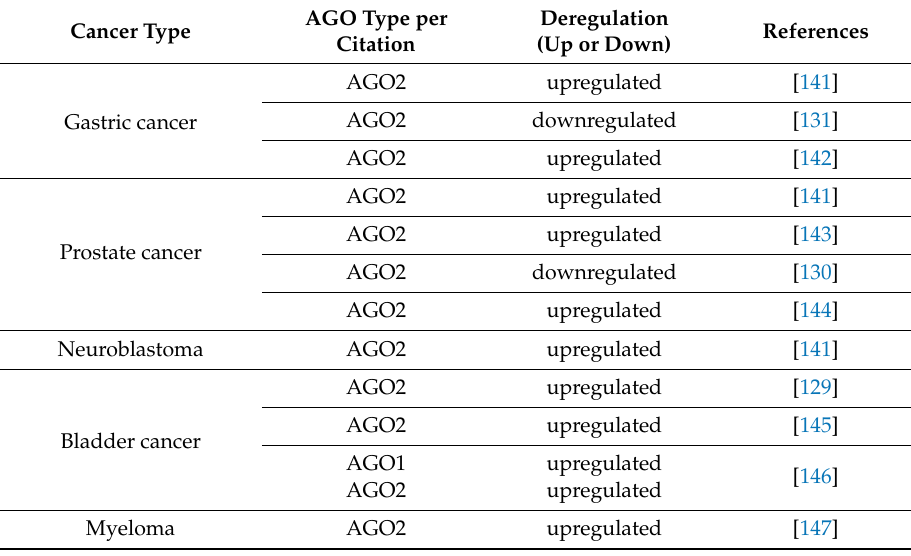
Table 1. AGO-deregulation profiling in human